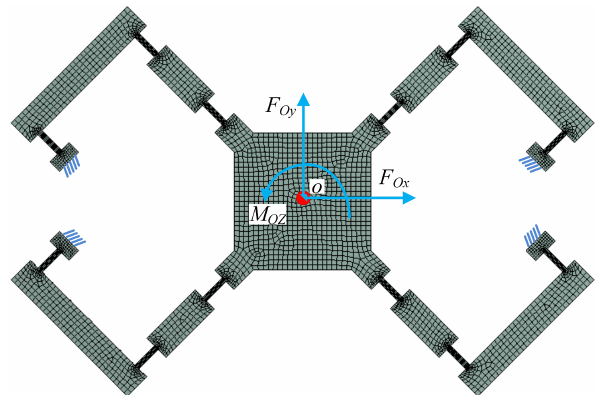
Figure 10. FEA model of a 4-RRR flexure-based compliant micro- motion